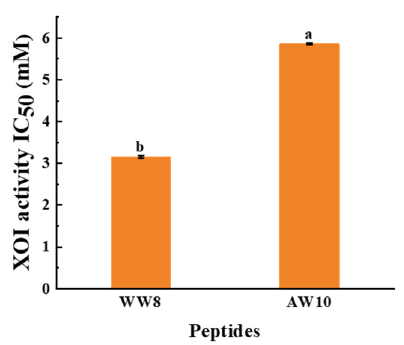
Figure 3. Identification results of WDDMEKIW and APPERKYSVW.